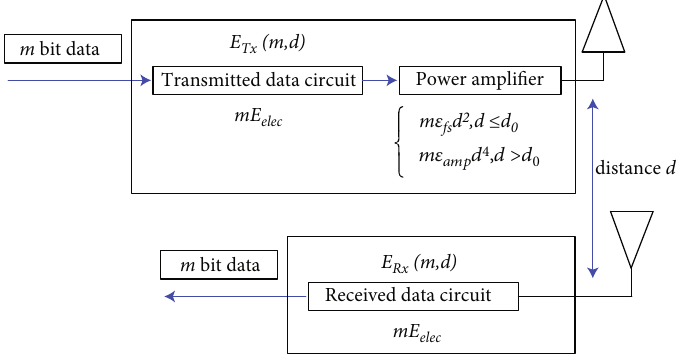
Figure 1: Energy consumption model.